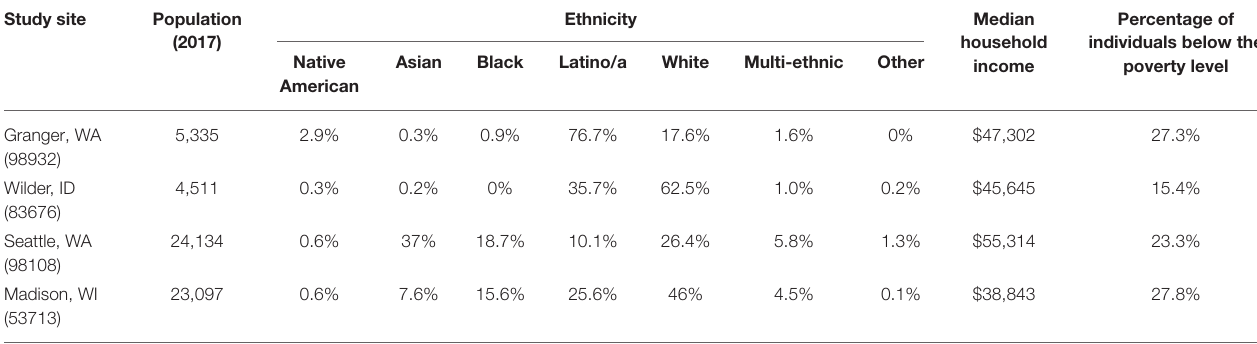
TABLE 1 | 2017 Demographic data of the four study communities (34). Study